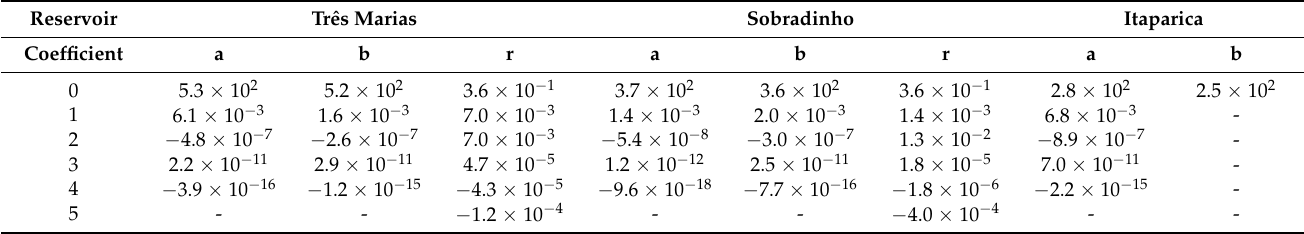
Table 5. Values of polynomial coefficients.